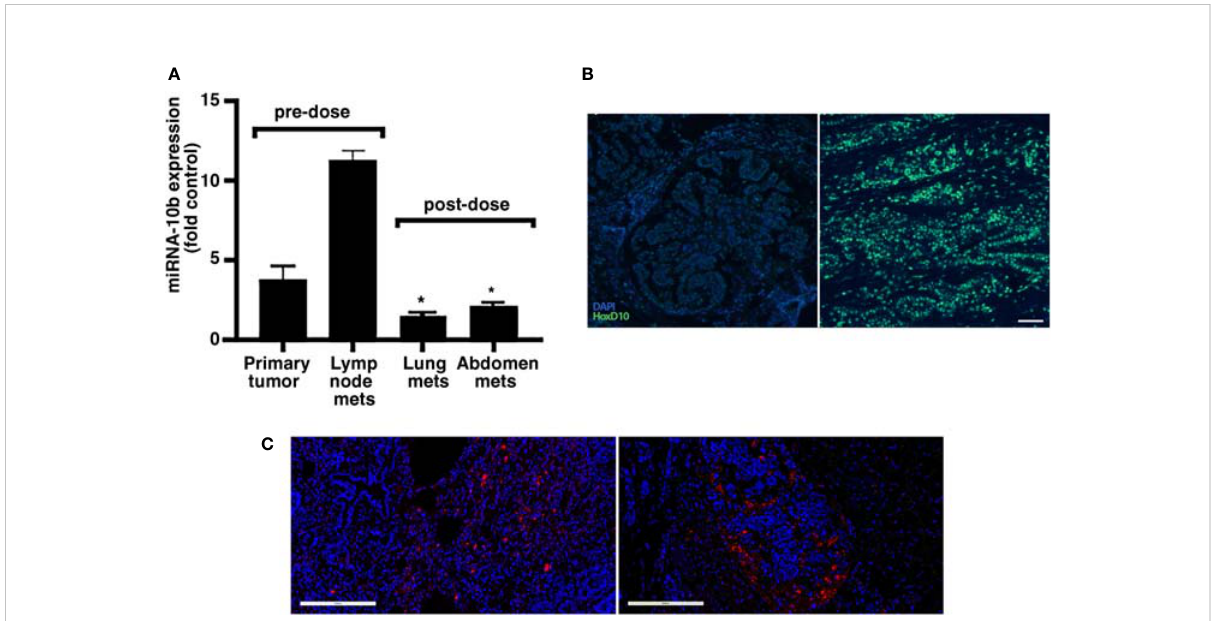
FIGURE 4 Target engagement and accumulation of MN-anti-miR10b in a patient with FMC. (A) qRT-PCR of miR-10b expression in primary tumor and lymph node metastases before dosing, and lung metastases and abdominal metastases three months after second. The expression of miR-10b was signi fi cantly reduced post-dosing relative to pre-dosing, indicating successful target engagement (n = 3, p < 0.05). Data are represented as mean ± s.d. (B) In situ hybridization demonstrating signi fi cantly increased HOXD10 expression in metastatic lesions after dosing compared to that in tissues isolated during original tumor excision. Scale bar = 100µm. (C) Fluorescence microscopy demonstrating accumulation of MN- anti-miR10b in lung metastases (left) and abdominal area metastases (right) three months after second dose. Scale bar = 200µm. This symbol * means that the data are statistically signi fi cant (i.e.